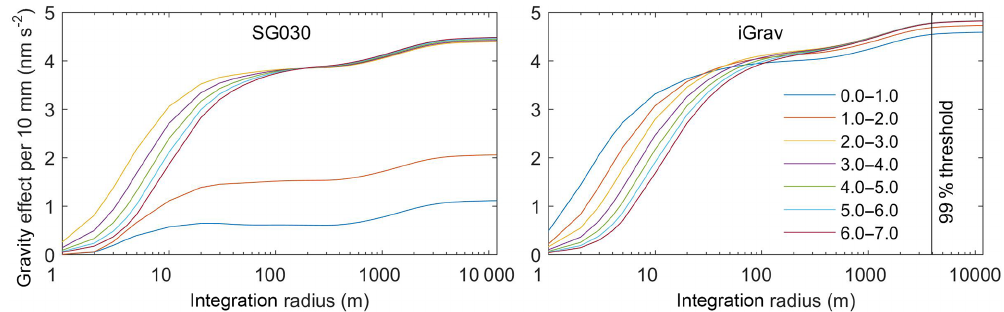
Figure 8. Gravity effect of a 10mm water storage change in different depths below the terrain surface (0–7m depth) at Wettzell, considering the real topography and the umbrella effect of SG030 gravimeter building and the iGrav pillar, respectively (there was no storage change within 2m underneath the building and